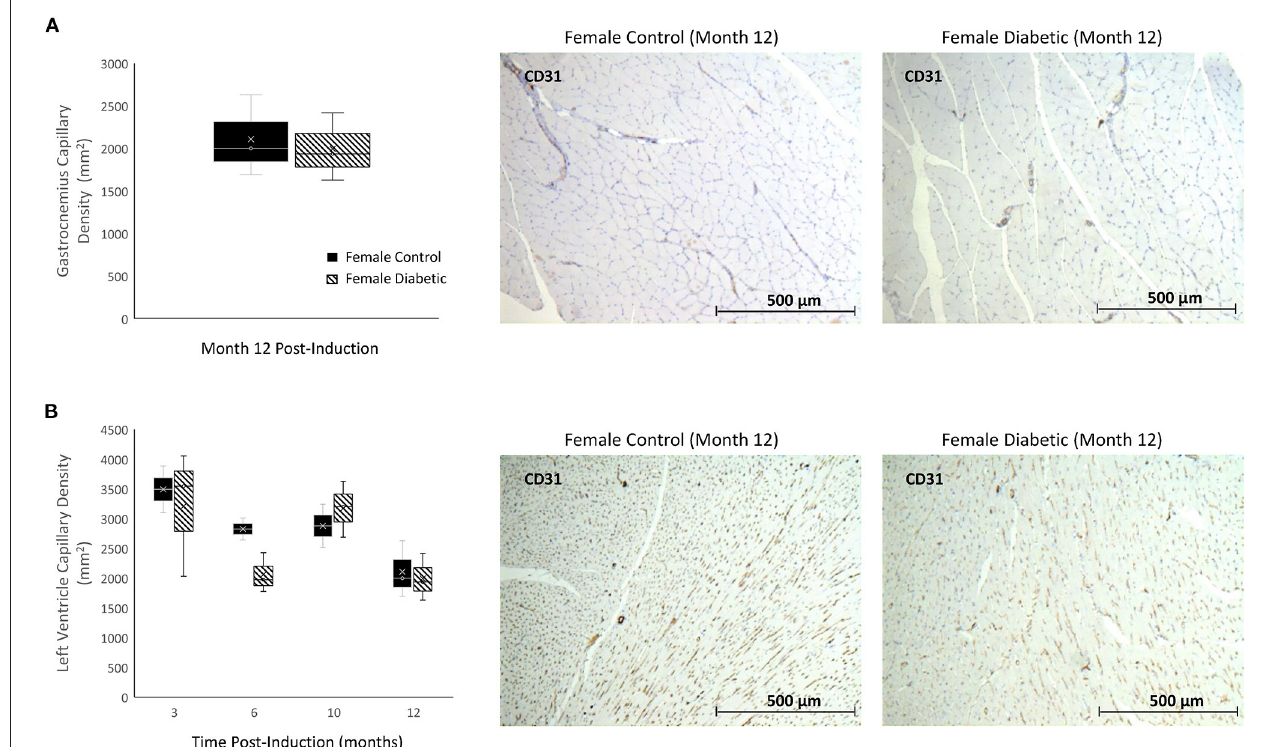
FIGURE 3 | Histology of skeletal and myocardial muscle capillary density reveals no rarefaction. Timepoints refer to time post-induction at 3 months ( n = 2 control female and n = 3 diabetic female), 6 months ( n = 2 control female and n = 3 diabetic female), 10 months ( n = 2 control female and n = 3 diabetic female), and 12 months ( n = 3 control female and n = 3 diabetic female) post-induction. Gastrocnemius (A) and myocardial muscle (B) capillary density quantified as the number of microvessels per mm 2 of tissue on CD31 stained sections. Representative images of skeletal and cardiac sections stained for CD31 from female control (middle) and diabetic (right) rats at 12 months post-induction. Boxplot mean value is represented with the symbol “X.” Results for male rats are shown in reference (8).